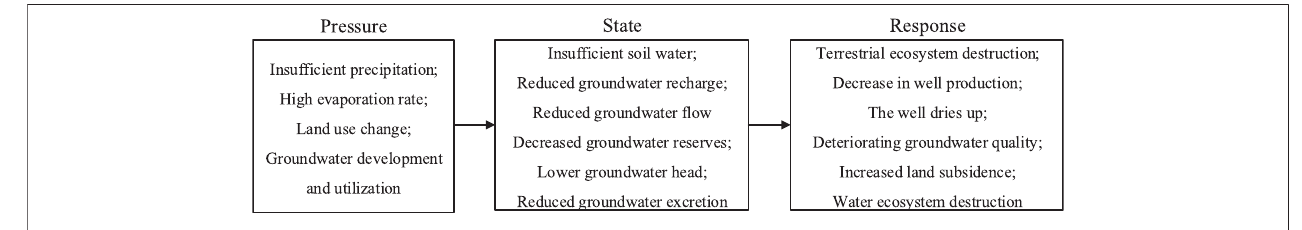
FIGURE 1 | Schematic diagram of groundwater drought pressure, state, and